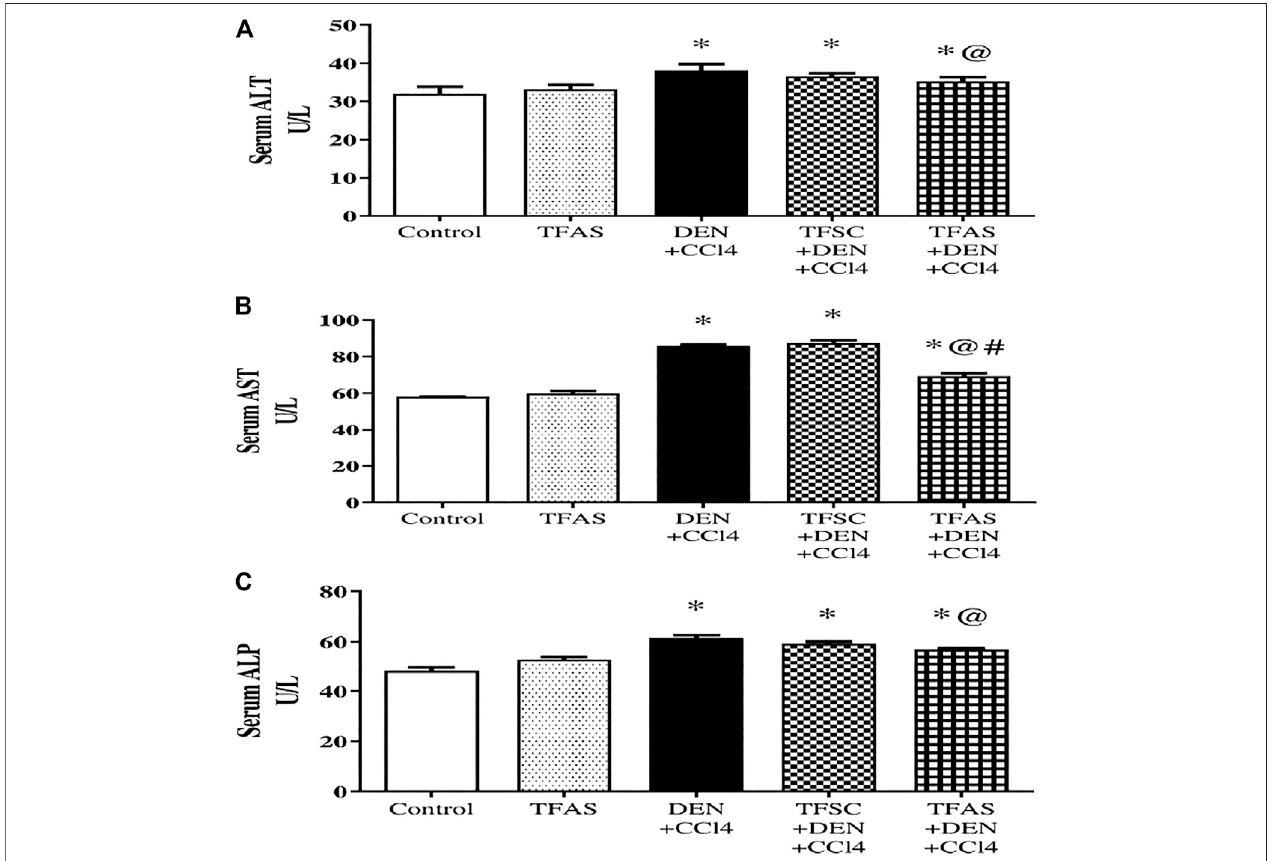
FIGURE4| EffectofTF-ODNsonserumactivitiesofALT,ASTandALPenzymes.LiverenzymesactivitiesofALT,ASTandALParepresented in fi gure (A) , (B) and (C) ,respectively.Dataareexpressedasmean ± SEM(n (cid:1) 8).(*),(@)and(#)indicatesigni fi cantdifferencefromControl,DEN+CCl4andTFSC+DEN+CCl4,respectivelyat P < 0.05usingone-wayANOVAfollowedbyTukey-Kramerpost-Hoctest.ALT:alanineaminotransferase;AST:aspartateaminotransferase;ALP:alkalinephosphatase; DEN: N-diethyl nitrosamine; CCl4: carbon tetrachloride; TFSC: scrambled tissue factor oligodeoxynucleotides; TFAS: antisense tissue factor